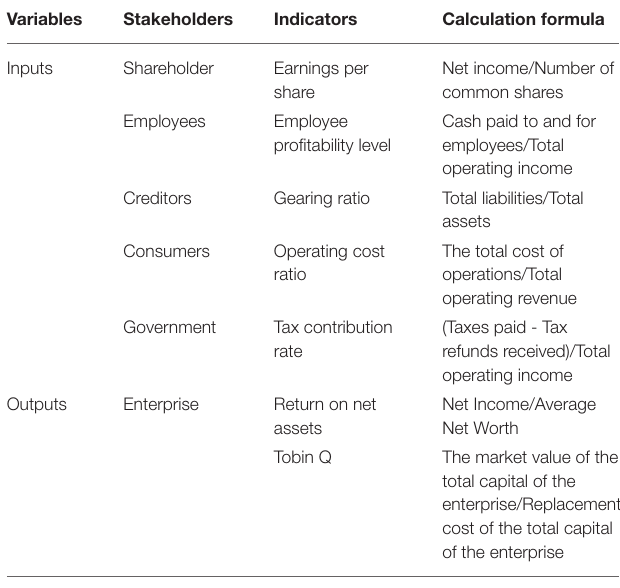
TABLE 1 | Input-output index system of corporate social responsibility (CSR) in food